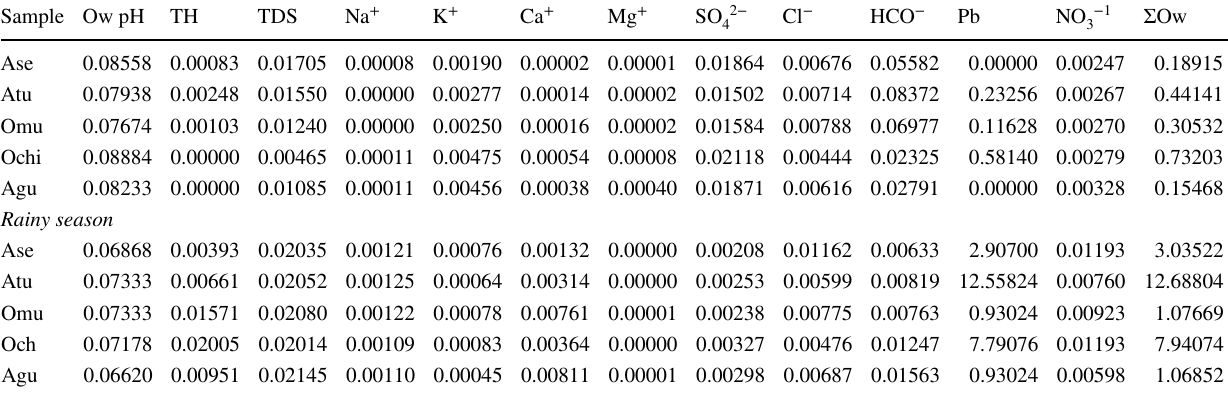
Table 8 Pollution index of the spring water (PIS) (ΣOw) and the overall water quality (Ow) Sample Ow